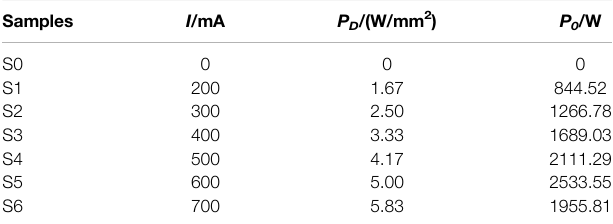
TABLE 1| Powerdensity andpower shocked onthecoatings duringthetransient thermal shock tests. I: EB current, P D : EB power density, P o : power shocked on the